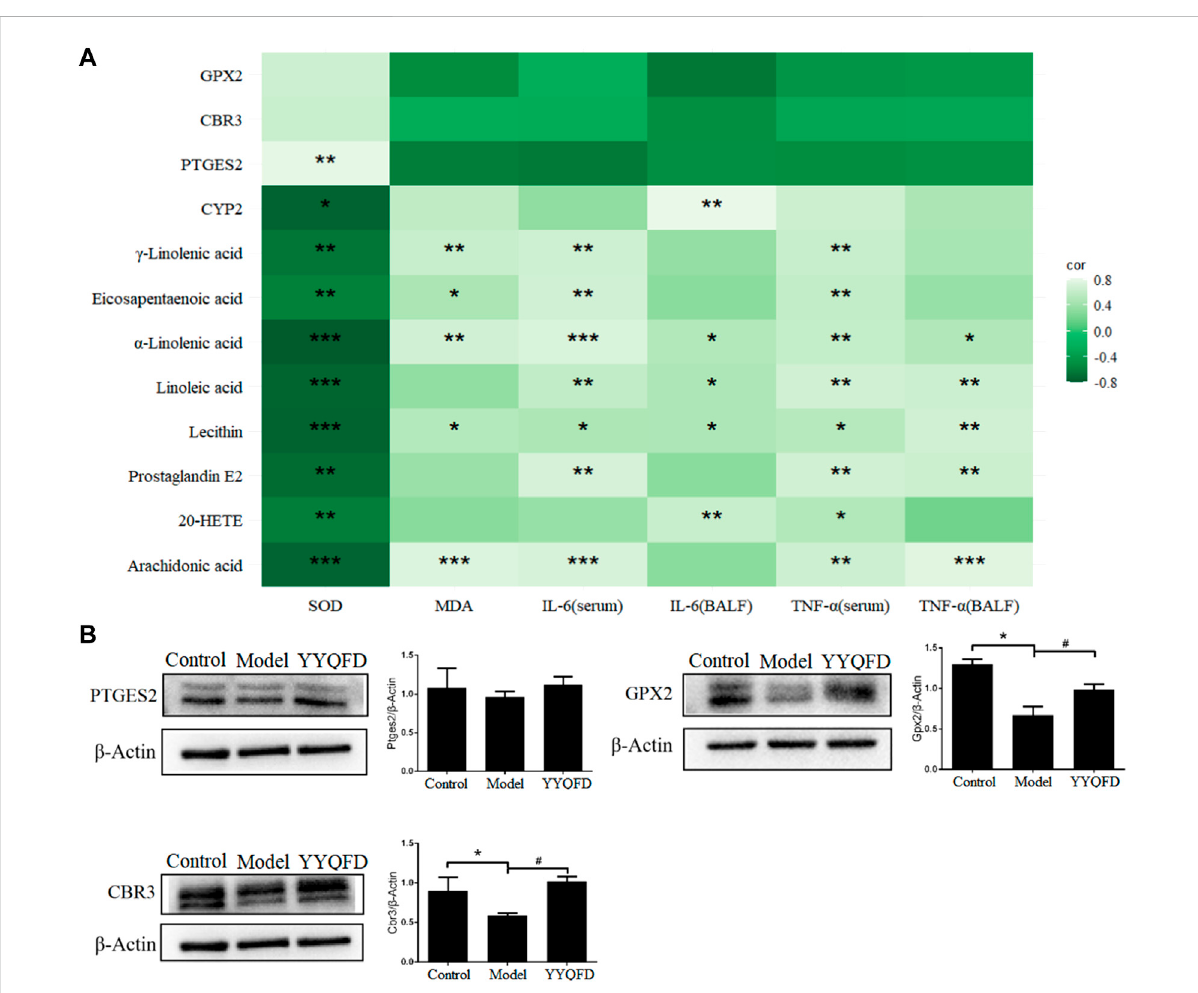
FIGURE 7 Correlation of differential metabolites and proteins with IL-6, TNF- α , MDA and SOD (A) , * p < 0.05, ** p < 0.01, *** p < 0.001; the expression of PTGES2, GPX2 and CBR3 proteins in lung tissue of mice among the control, model and YYQFD group (B) , * p < 0.05 vs. control group, # p < 0.05 vs. model